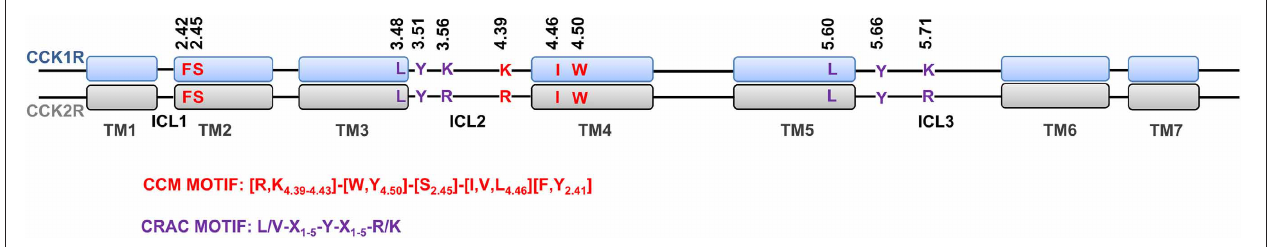
FIGURE 1 | Schematic representation of the alignment of structural segments of the CCK1R and CCK2R. The CCM (red) and the CRAC (violet) are highlighted within the transmembrane segments (rectangles) and intracellular loops (black line) of the CCK1R (top, blue) and CCK2R (bottom,